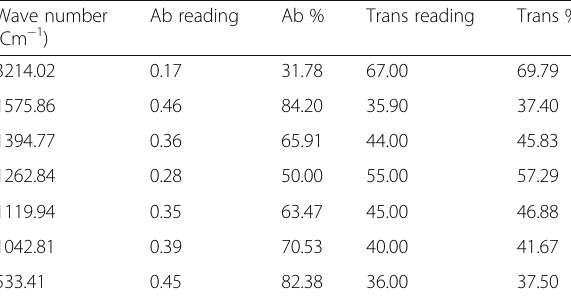
Table 5 The FT-IR measurements showing absorbance and transmittance of the bioactive compounds in the M. oleifera leaves extract before incorporating Ag-NPs Wave number (Cm − 1 )